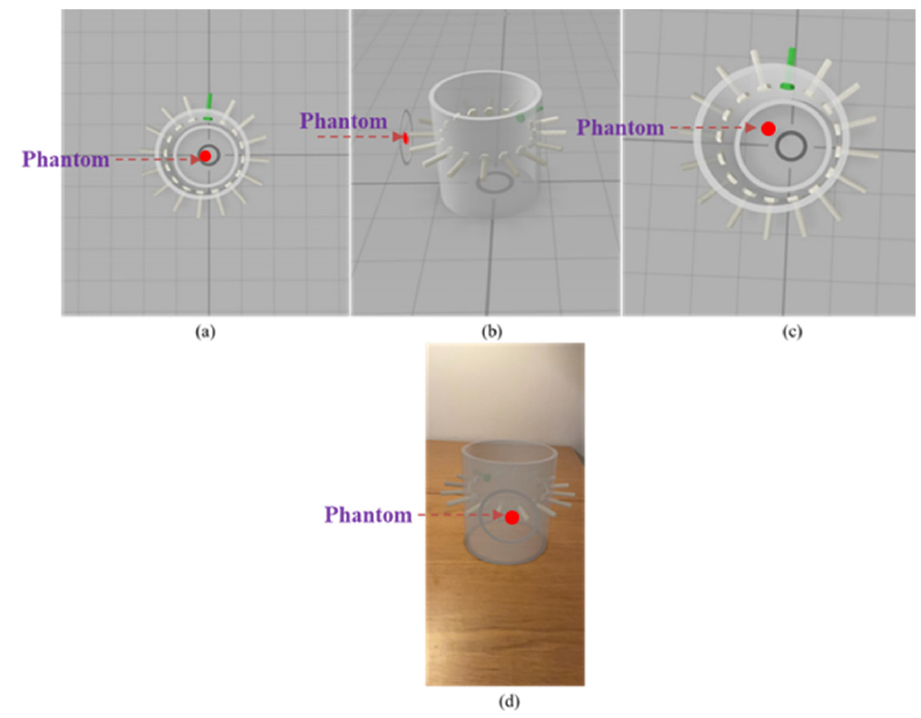
Figure 16. Smart visualization object displayed in Reality Composer application: ( a ) inside view, ( b ) superimposed view, ( c ) phantom position at P7, ( d ) AR testing on horizontal surface. In this research, only offline visualizations are proposed. The geometrical parameters computed from the static testing mentioned in Tables 2–4 were used to change the phan- tom position. The parameters were passed as an array with a delay of 1s between each consecutive point